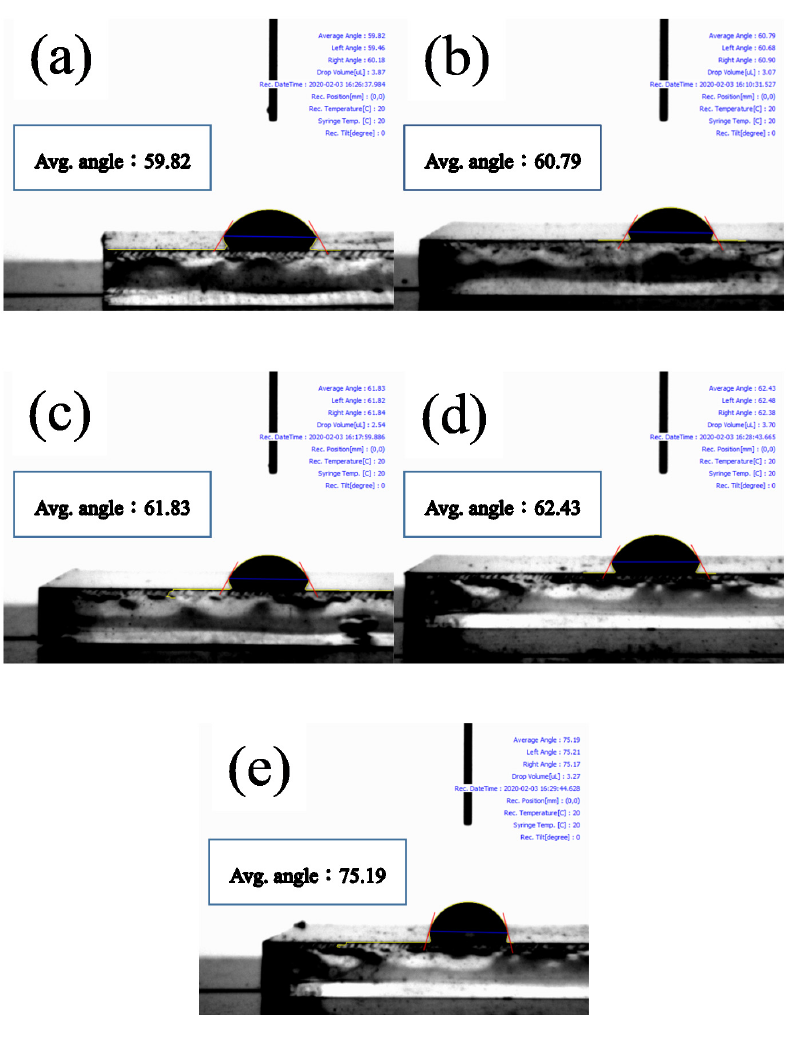
Figure 3. SEM images of the MAPbI 3 layers over the FTO/NiO X /POSS with various POSS contents: ( a , b ) control; ( c , d ) POSS-0.005; ( e , f ) POSS-0.01; ( g , h ) POSS-0.015; and ( i , j ) POSS-0.05. The magnifi- cation in the left images and the right images are x30k and x50k, respectively.